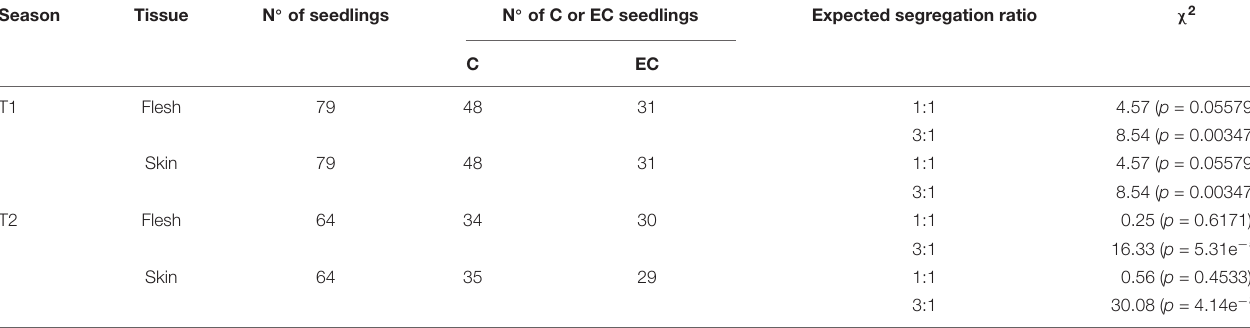
TABLE 1 | Segregation analysis of the Japanese plum seedlings having a high content of catechin (C) or epicatechin (EC). Season Tissue N ◦ of seedlings N ◦ of C or EC